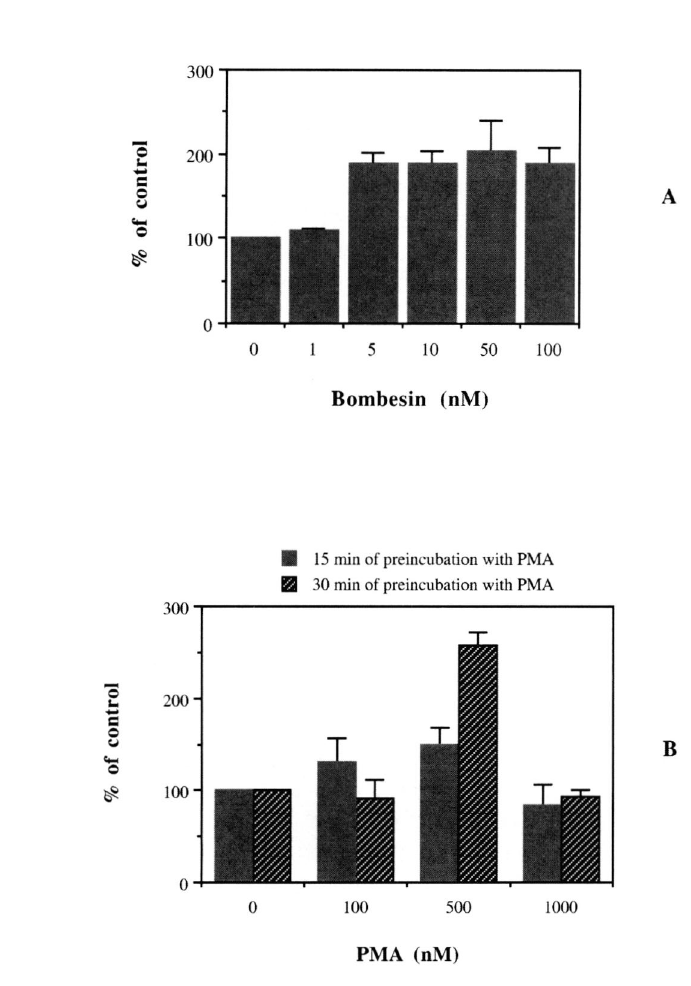
Fig. 3- - Effects of MAP kinase and PKC activators on Toxoplasma infectivity. Toxoplasma tachyzoites were preincubated with increasing concen­ trations of bombesin for 15 min (A), or PMA for 15 min, or 30 min (B). The efficacy of invasion was evaluated by microscopic counting of the percentage of infected cells after immunofluorescence staining. Results are expressed as relative percentages, corresponding to the relative increase of cell infection, compared to control values (cell infection by untreated tachyzoites, i.e., 20.2 ± 5.5 % in (A), 18.5 ± 2.1 % in (B)), arbitrarily brought to 100 %. Data are means ± SE of three independent